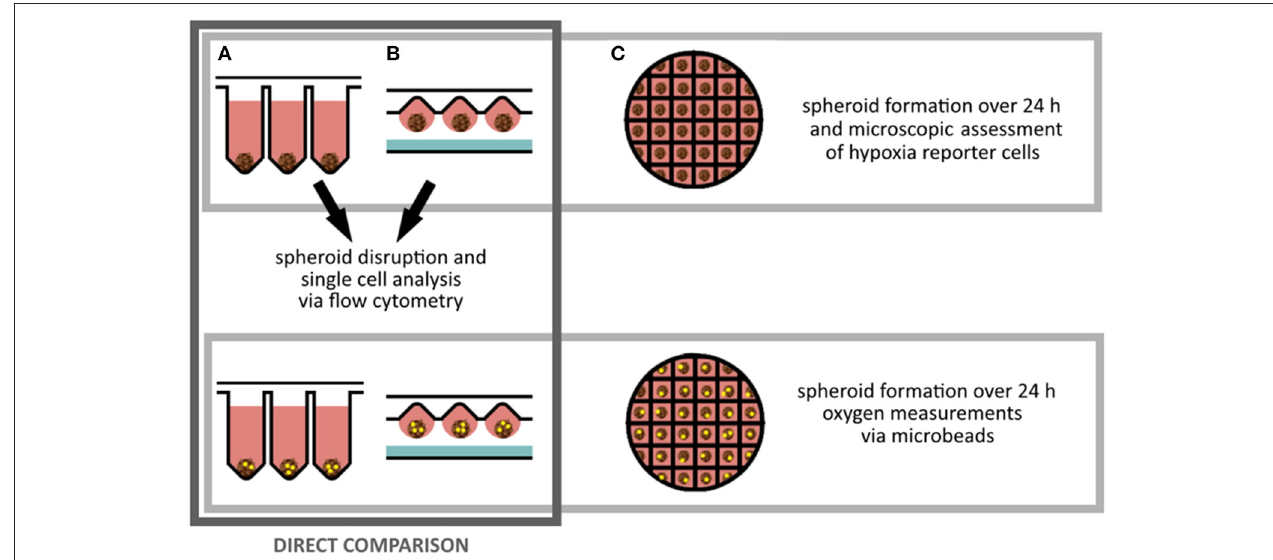
FIGURE 1 | Experimental planning: Spheroids of MSC reporter cells were fabricated for 24h on three different platforms. (A) Ultra low attachment plates, (B) by hanging drop method, (C) on microstructured plates. Spheroids created on ultra low attachment plates and by hanging drop method were singularized for flow cytometry analysis to investigate the sensor cell output. For all methods oxygen sensitive microbeads were applied to determine local oxygen concentrations inside of the spheroids.